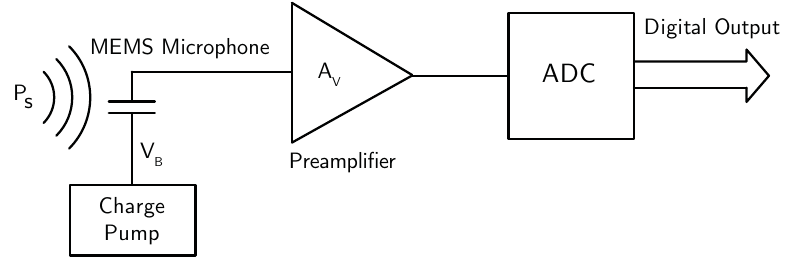
Figure 4. Typical block diagram of the interface circuit for a MEMS microphone.